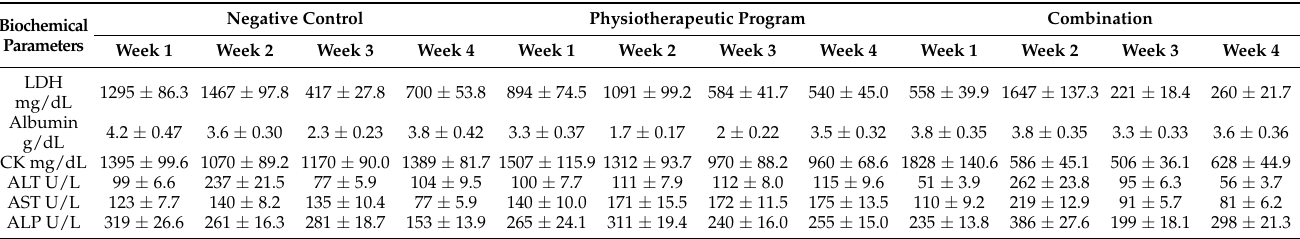
Table 2. Biochemical parameters of the experimental rat groups.